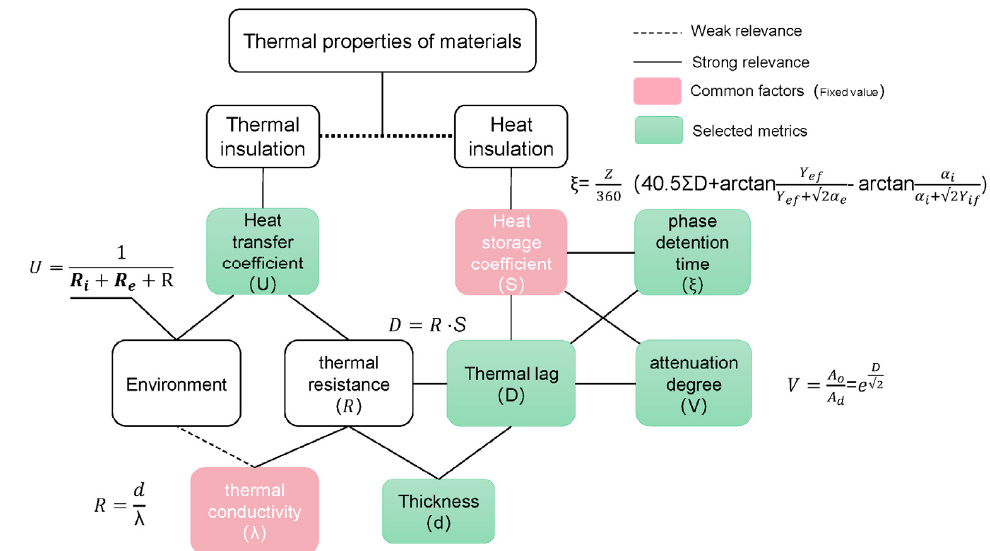
Figure 4. Relevance of the material’s thermal